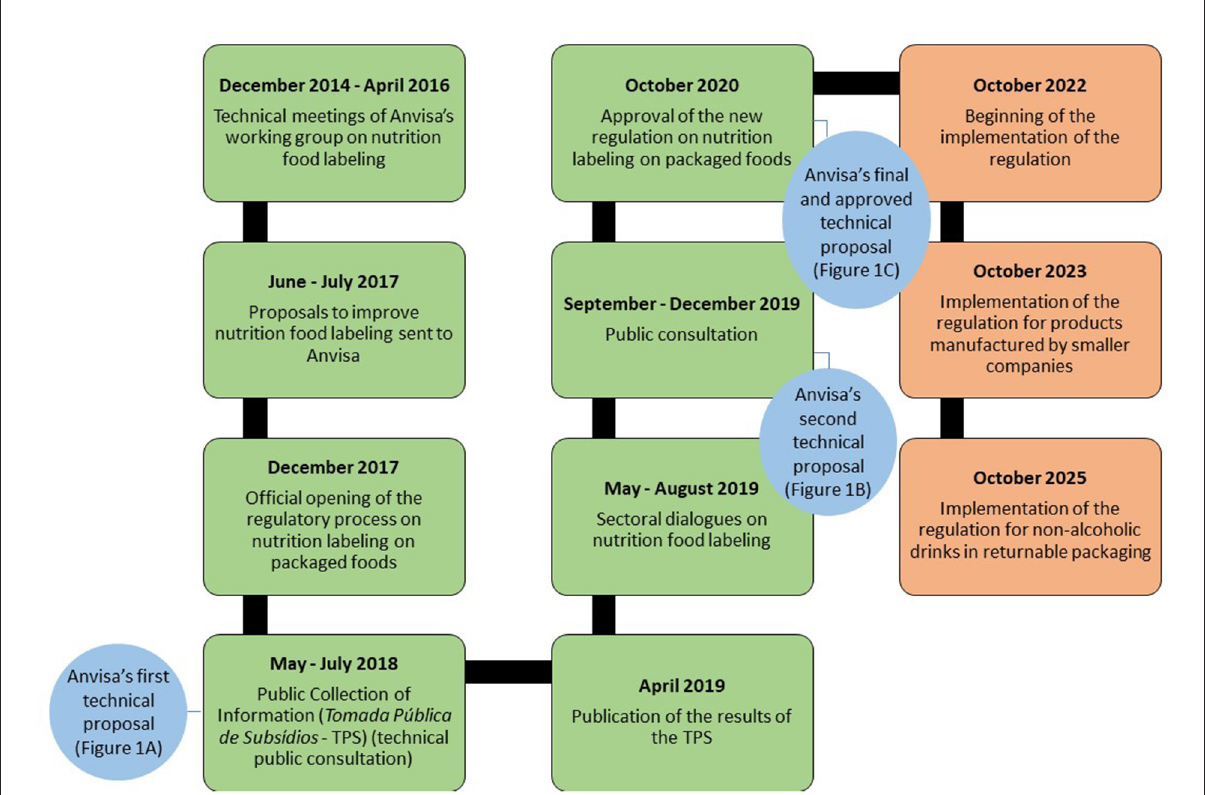
FIGURE2 Timeline of the regulatory process of nutrition labeling on packaged foods and its implementation. Brazil, 2014–2025. Boxes in green contemplate events of the regulatory process that have already happened. Boxes in red contemplate events predicted to happen in the next years. Circles in blue represent Anvisa’s technical proposals throughout the regulatory